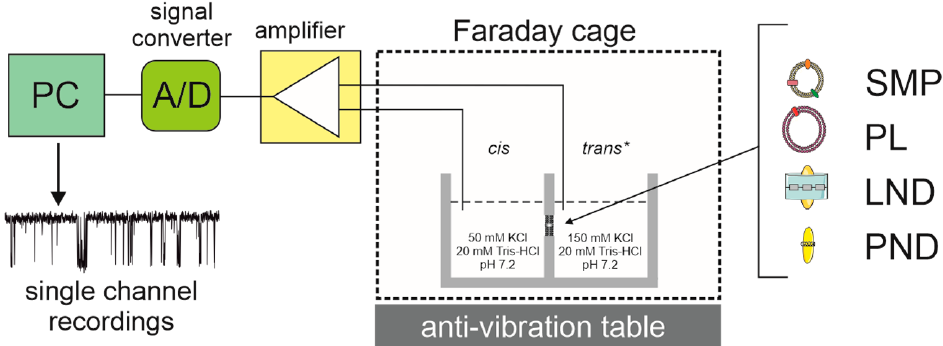
Figure 2. Planar lipid bilayers (PLBs) were used to record mitochondrial K + channel activity. The main PLB equipment includes a personal computer (PC) with software, a signal converter (A/D),